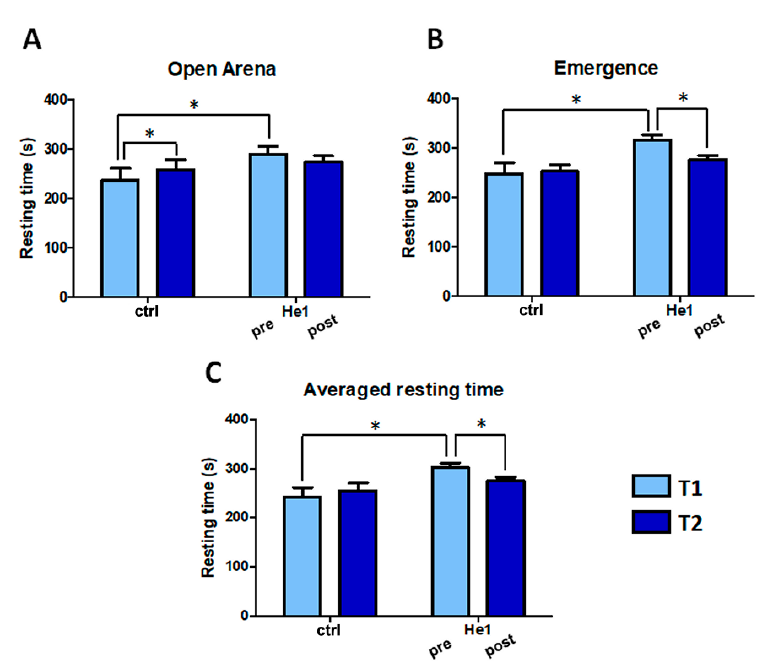
Figure 3. H. erinaceus treatment reverted the resting time increase during aging: mean resting time (s) estimated during open arena (Panel A ) and emergence tasks (Panel B ). Panel C : Averaged resting time obtained by both tasks, in untreated (ctrl) and He1 treated mice (He1) before (T1) and after (T2) treatment. Two-way ANOVA was performed for statistical analysis: * p < 0.05.